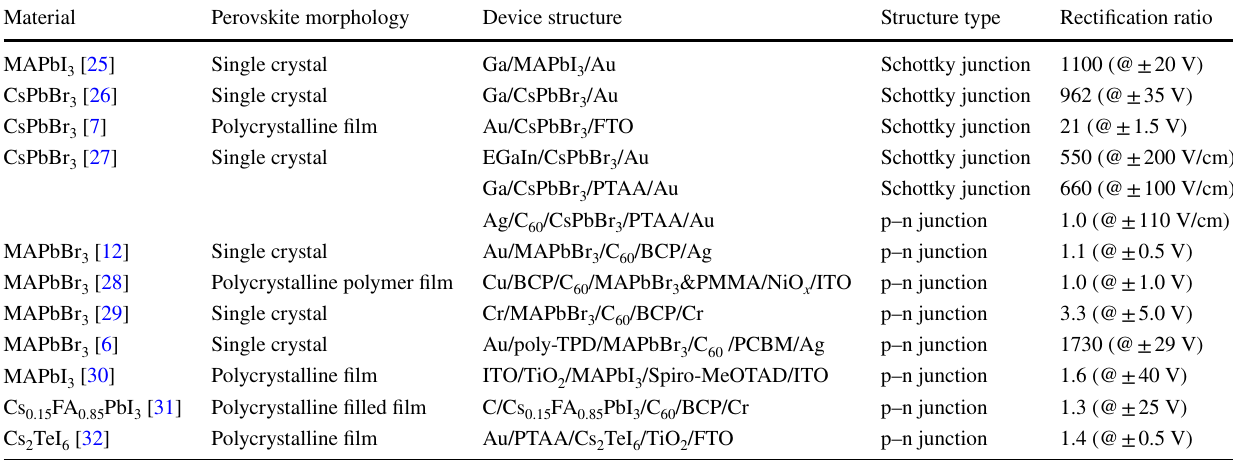
Table 1 Summary of the junction structures and rectification ratios of MHP polycrystalline thick film or bulk single crystal detection devices Material